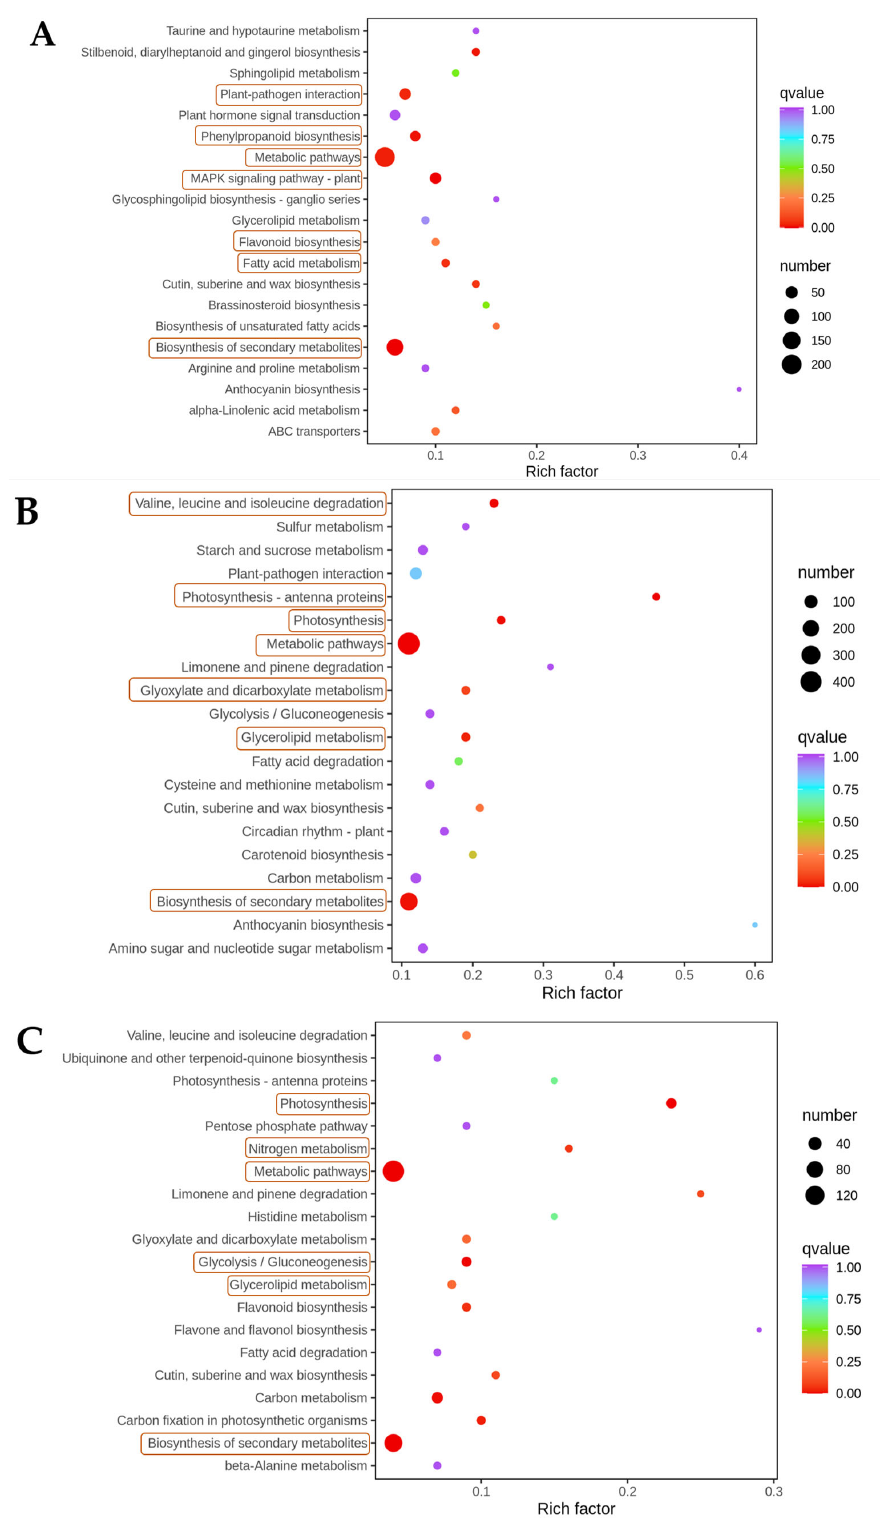
Figure 6. Statistics of transcriptomic KEGG enrichment in the ( A ) GR, ( B ) BR+3, and ( C ) BR+9. The vertical coordinate represents the KEGG pathway. The horizontal coordinate indicates the rich factor; the larger the rich factor, the greater the enrichment. The larger the dot, the greater the number of differential genes enriched in the pathway. The redder the color of the dot, the more significant the enrichment. Enrichment is significant in the pathway labeled